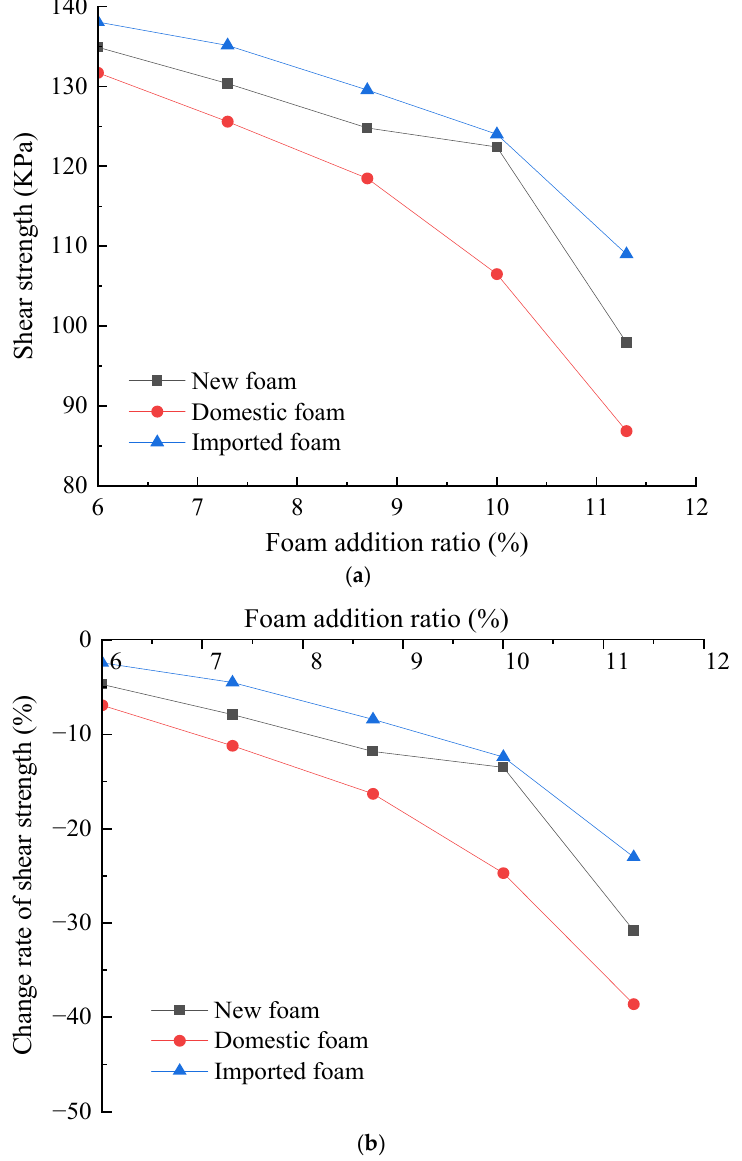
Figure 16. Comparison of shear strength and change rate of shear strength of sand after improvement of different foam agents. ( a ) Shear strength change curve. ( b ) Shear strength change rate curve.